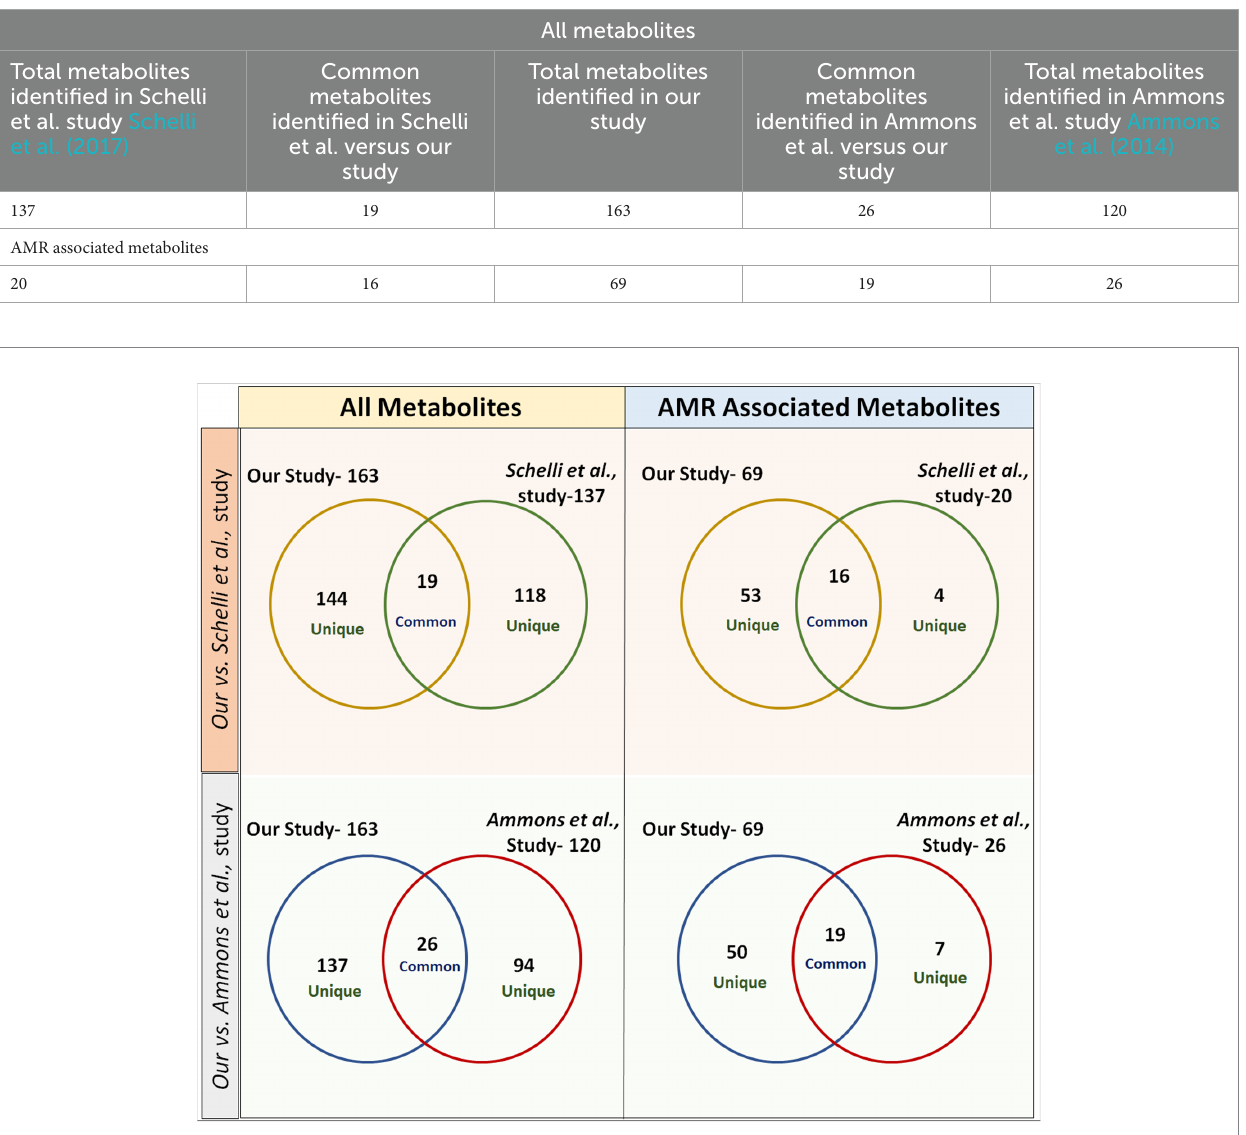
FIGURE 5 Venn diagrams representing a comparison of metabolites identified from our study versus previously published studies in the domain. In study-1 (Ammons et al.), 26 metabolites were found to be common in total metabolites and 19 metabolites were common in AMR-associated metabolites with our study. In study-2 (Schelli et al.), 19 metabolites were found to be common in total metabolites and 16 metabolites were common in AMR- associated metabolites with our